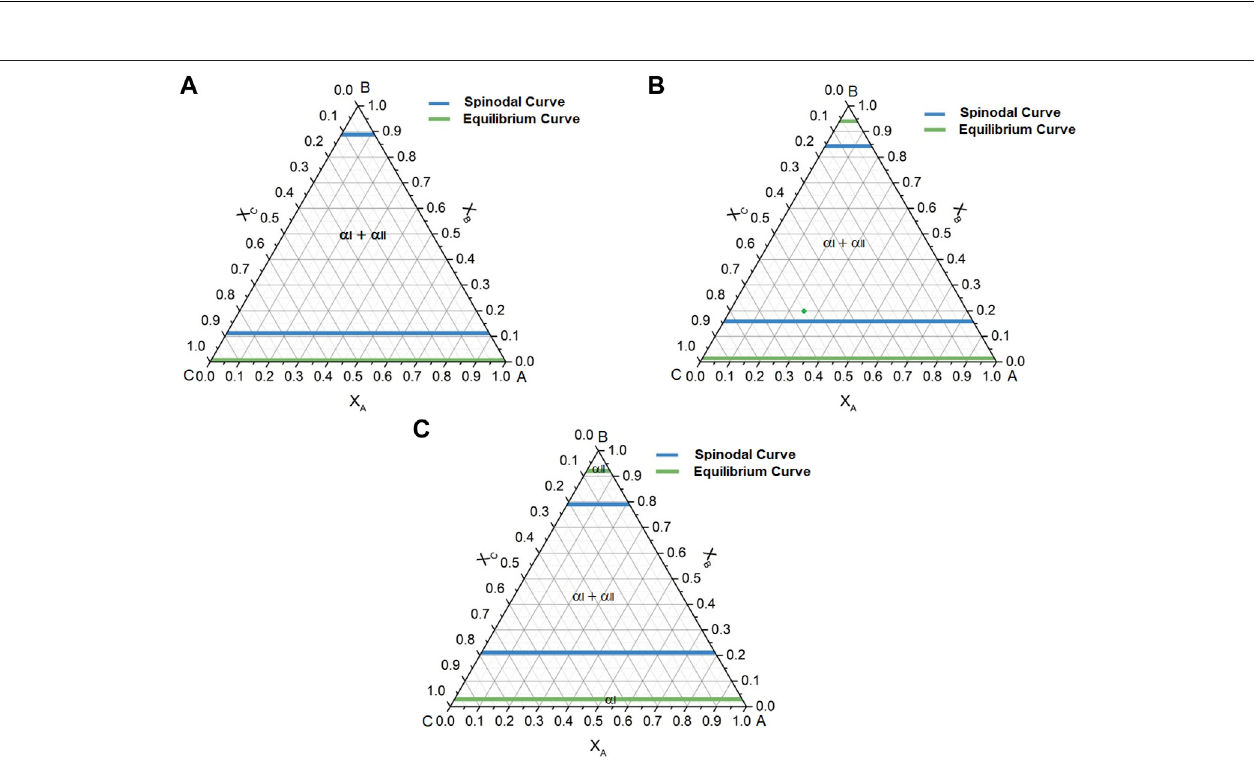
FIGURE 3 | Isothermal sections of the miscibility gap and spinodal curve for the A – B – C alloy system with Ω AB = Ω BC = 25,000 J/mol and Ω CA = 0 J/mol at (A) 600 K, (B) 800 K, and (C) 1000 K.